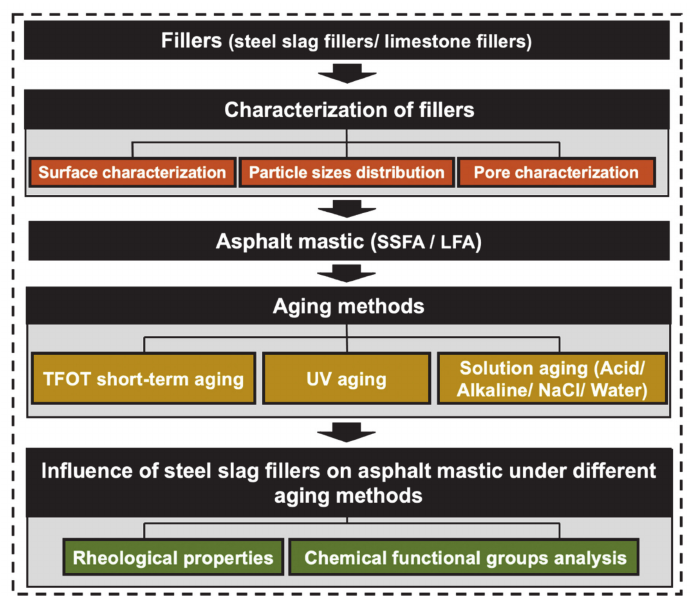
Figure 1. The flow chart of this